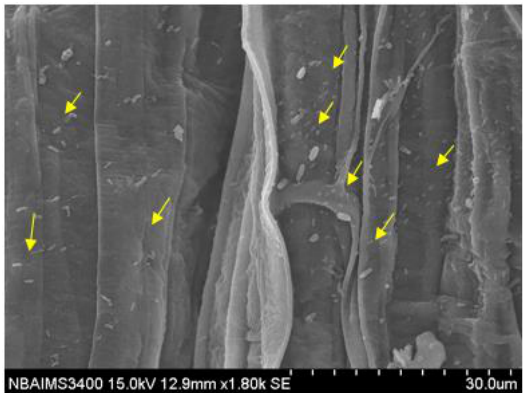
Figure 2. Scanning electron microphotographs showing root colonization of maize by Pseudomonas geniculata MF-84.